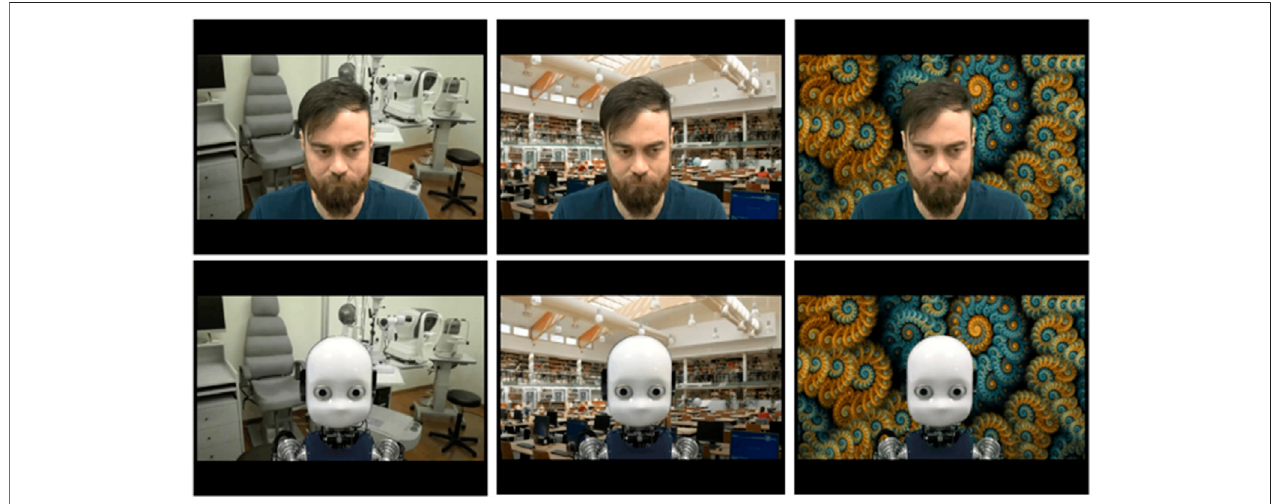
FIGURE 1 | Examples of videos used in the experiment. Other than the behavior of “ Calibrating ” and “ reading ” (not displayed), we manipulated the agent and the background. All the stimuli generated for this study were original; the human agent that was fi lmed and depicted in the image gave explicit consent for the use of the material included in the experiment and in the